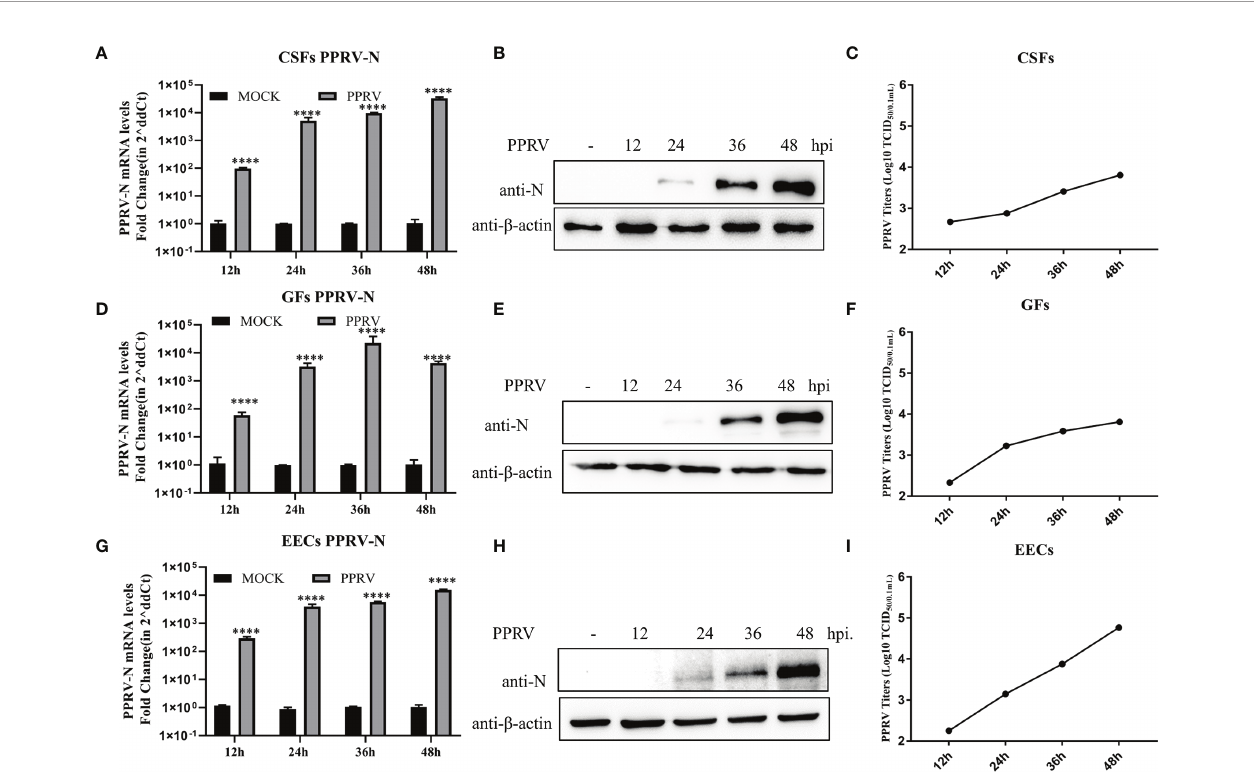
FIGURE 1 | PPRV proliferated in three types of goat cells. (A – C) Nucleoprotein mRNA, protein levels and viral titers in PPRV-infected CSFs were determined. (D – F) Nucleoprotein mRNA, protein levels, and viral titers in PPRV-infected GFs GFs were determined. (G, H) Nucleoprotein mRNA and protein levels and viral titers in PPRV-Infected EECs were determined. **** P <